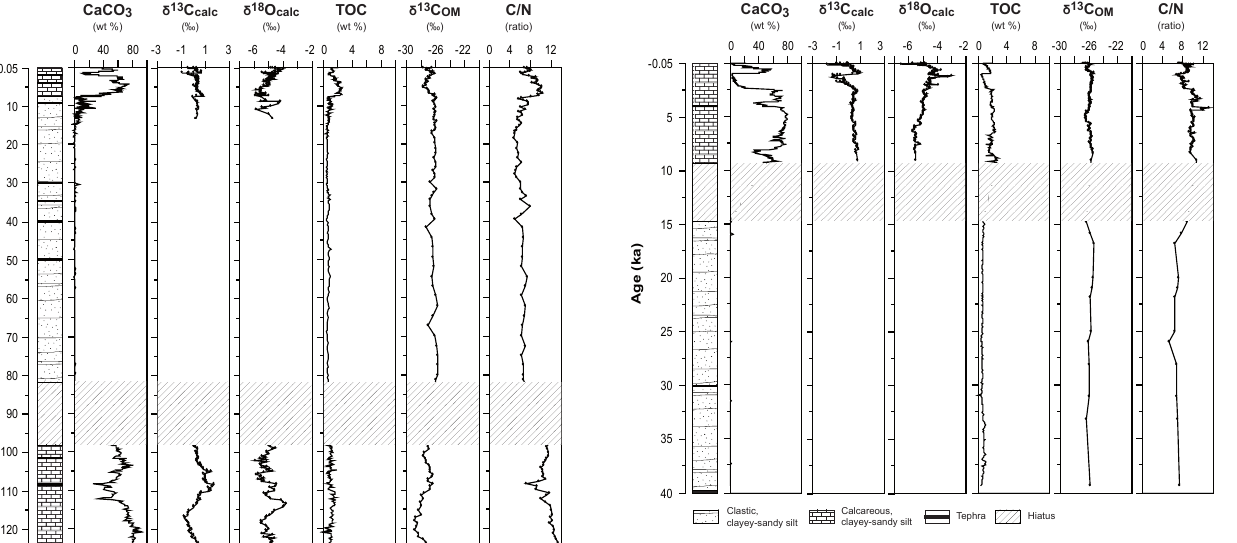
Fig. 5. Calcite and organic matter concentration and isotope data from Lake Ohrid core